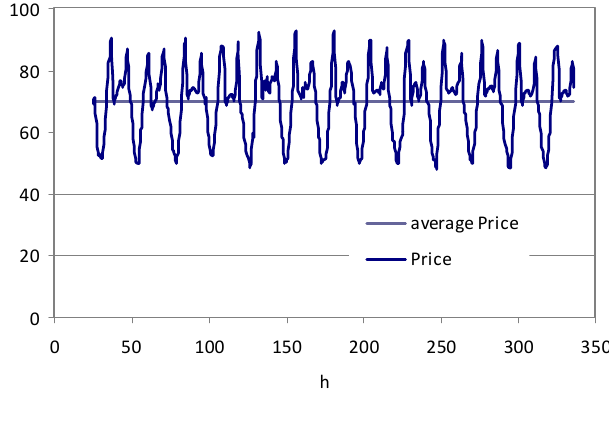
Figure 9. Price course along 14 days—stable